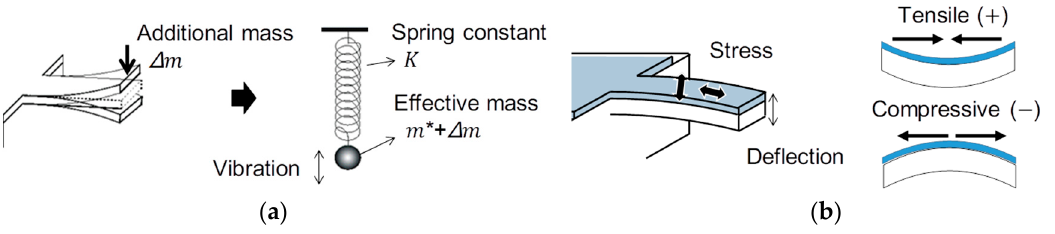
Figure 2. Principles of operation of the cantilever beam. ( a ) Equivalent spring and mass concept for simulation of vibrations of cantilever beam; ( b ) The bending mode of cantilever beam due to the stress on the surface, adopted from